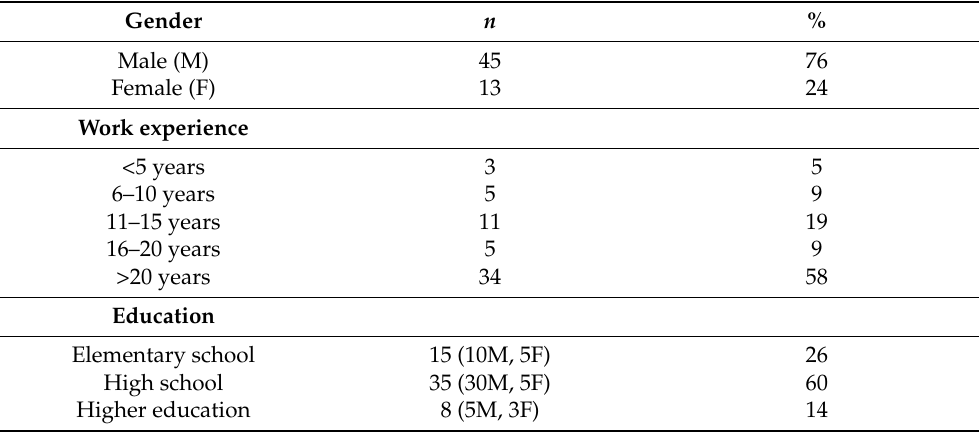
Table 2. Demographic data of the pig farmers ( n =